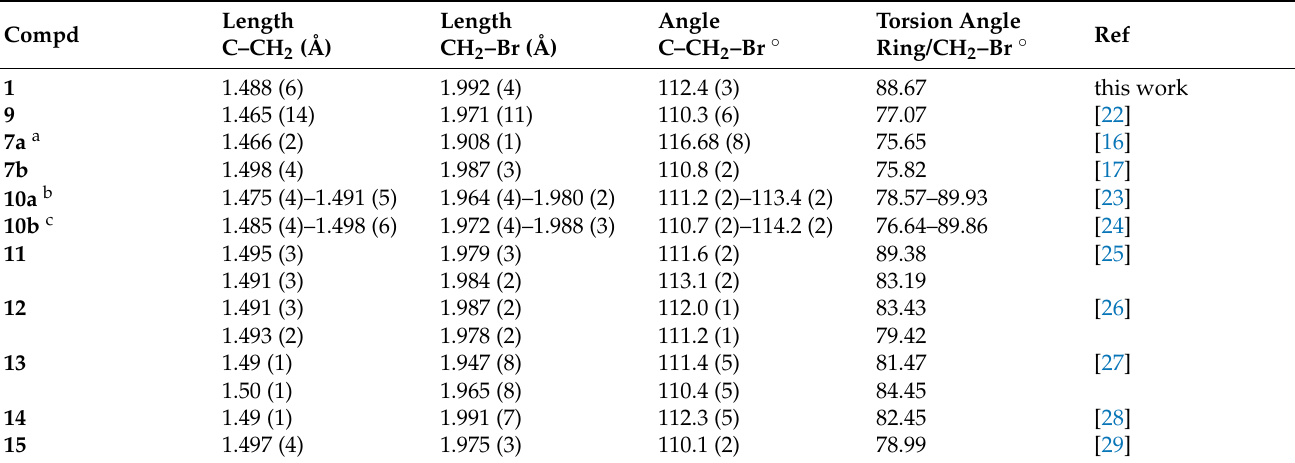
Figure 3. Comparison crystal structures with CSD reference codes. Table 1. Geometric parameters for 1 and other comparable benzyl bromides.